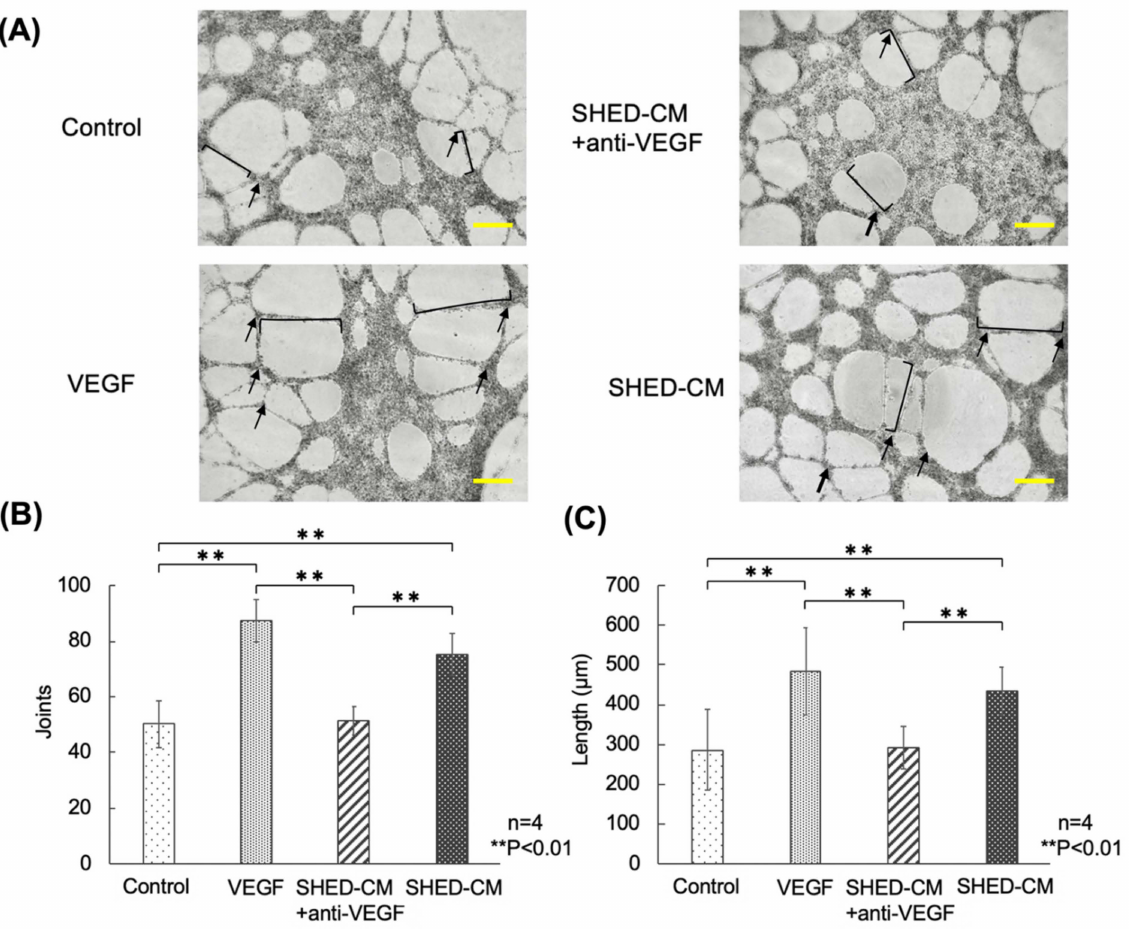
Figure 2. Effects of VEGF-A in SHED-CM on HUVEC lumen assembly. ( A ) Luminal view of HUVECs in the four groups. Lumen formation was observed more frequently in the SHED-CM- and VEGF-A-supplemented groups. Scale bar = 300 µ m. ( B ) Vascular bifurcation in the four groups. ( C ) Vessel length in the four groups ( n = 4, ** p < 0.01). Black lines indicate vessel length; black arrows indicate joints. SHED-CM, human deciduous dental pulp-derived mesenchymal stem cell-derived culture supernatant; VEGF-A, vascular endothelial growth factor-A; HUVECs, human umbilical vein endothelial